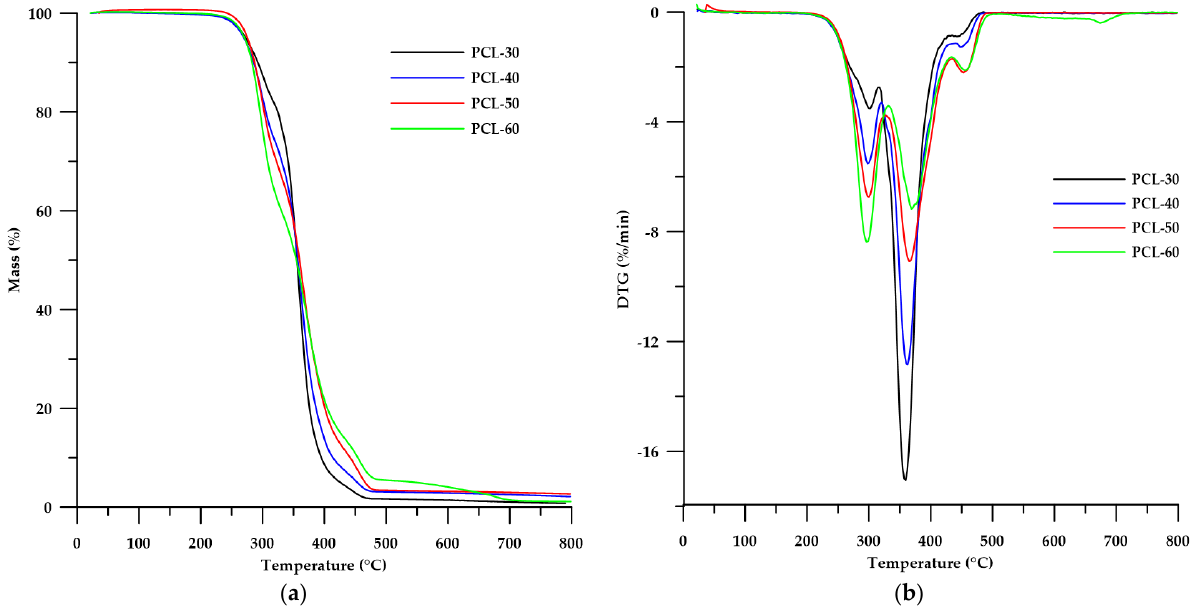
Figure 7. TG ( a ) and DTG ( b ) curves of the obtained polymers (in helium).